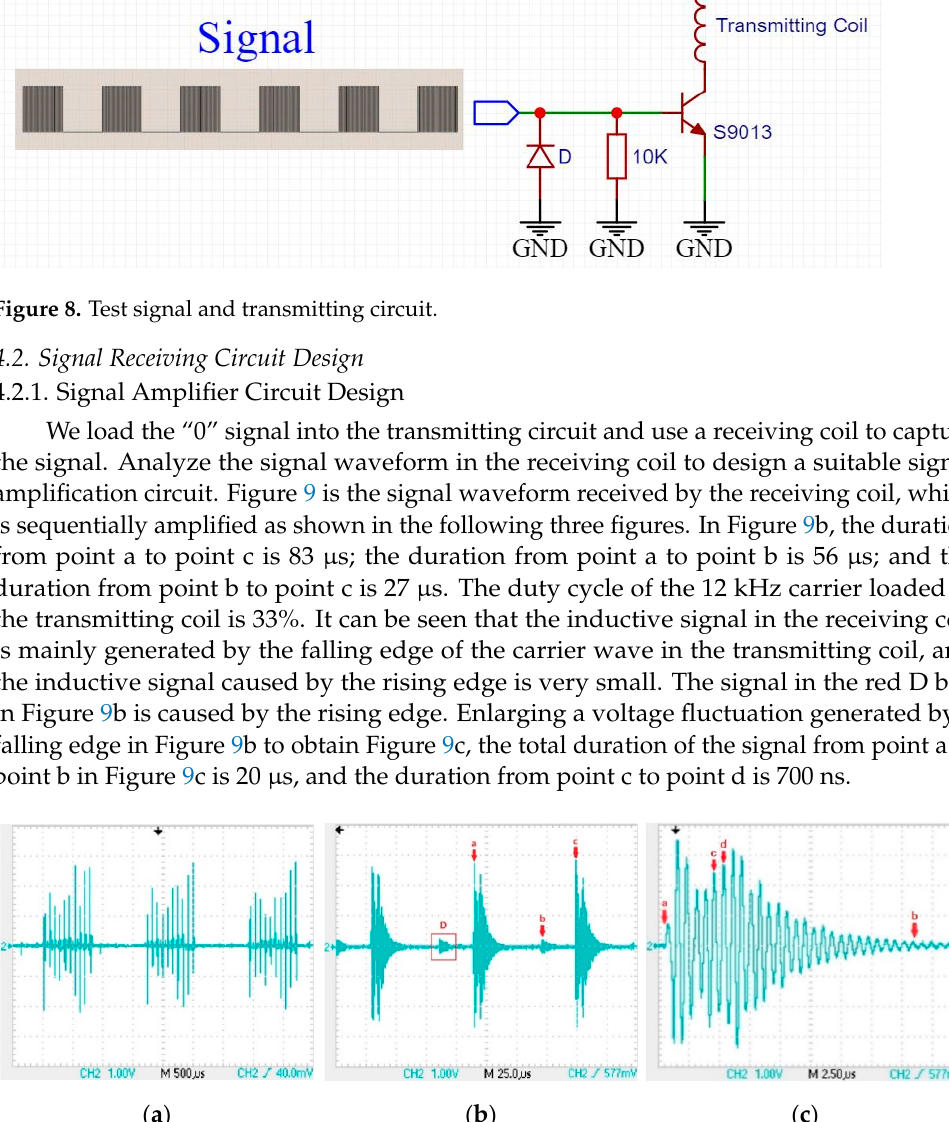
Figure 9. The waveform of the signal in the receiving coil: ( a ) signal waveform; ( b ) induced signal generated by continuous square wave in transmit coil; ( c ) oscillation signal generated by falling edge of square wave in transmitting coil.